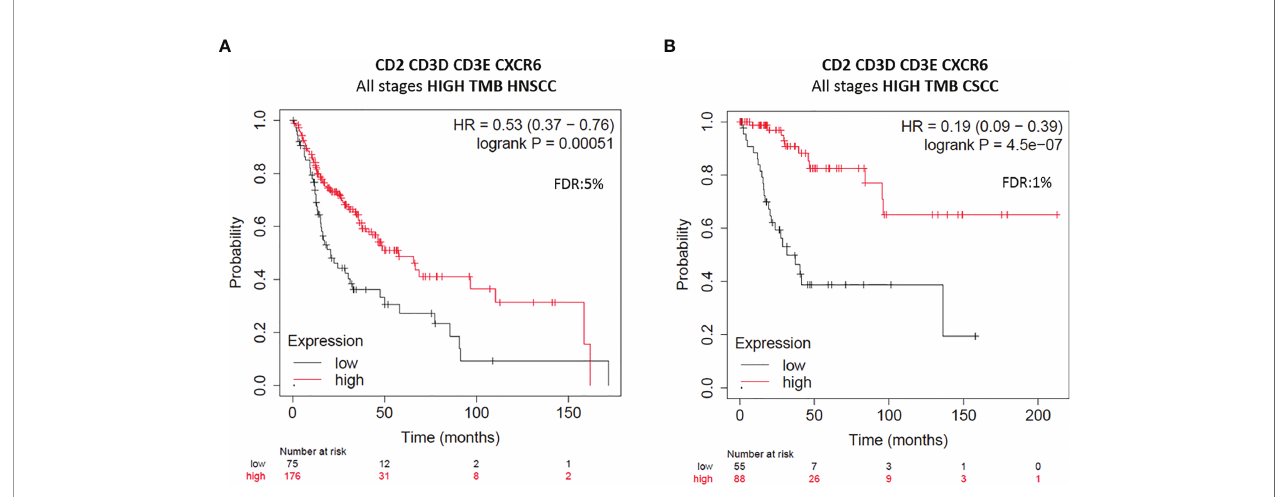
FIGURE 7 | Clinical outcome analysis of CD2 , CD3D , CD3E , CXCR6 immune gene signature expression in HNSCC and CSCC tumors with high mutational burden. Clinical outcomes of survival plots of new immune gene signature with improved favorable prognosis at all stages of HNSCC tumors (n = 251) (A) and CSCC tumors (n = 143) (B) with high mutational burden (TMB) are displayed. Red line represents survival of patients whose tumors harbor high gene expression levels, and those with low gene expression levels show in black line. Number of patients at risk at every time (months), with high (in red) and low gene expression (in black), is displayed. HR for risk of death and OS are displayed. HR < 0.65 discriminates a risk reduction. FDR is also displayed. The gene combination is displayed at the top of each fi